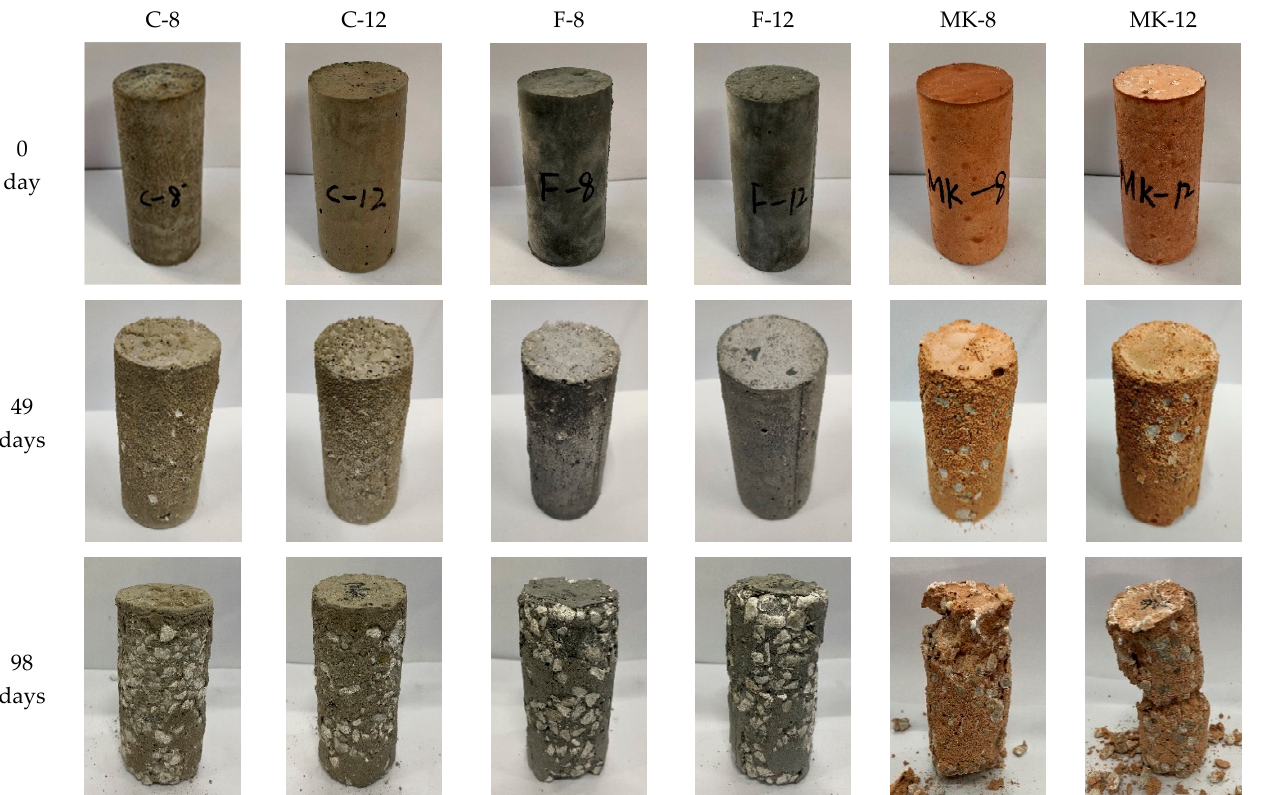
Figure 2. GPC after 0 day, 49 days, and 98 days of immersion in sulfuric acid solution.